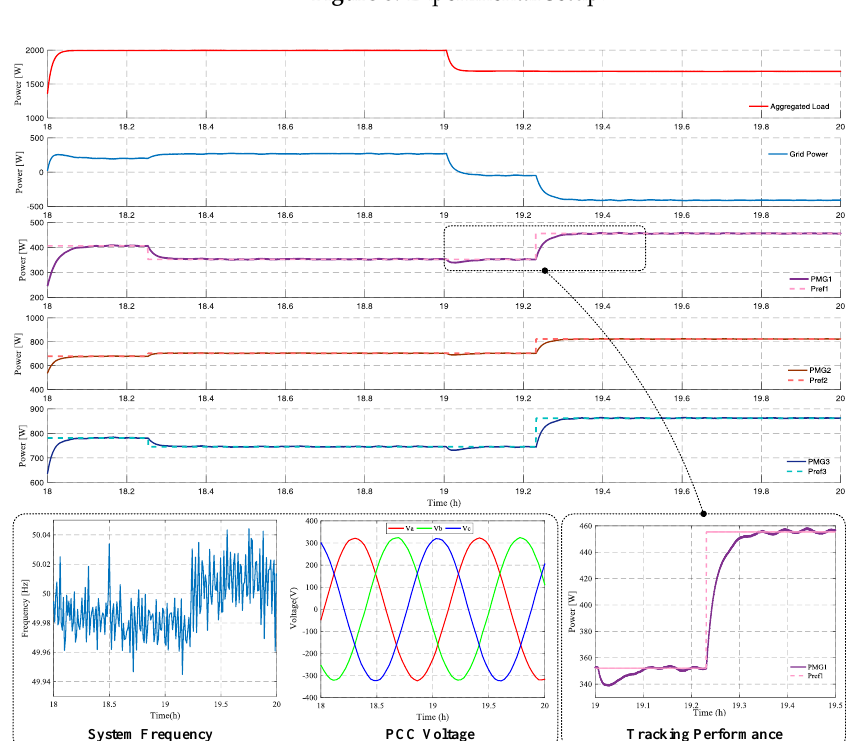
Figure 9. Tracking performance of local